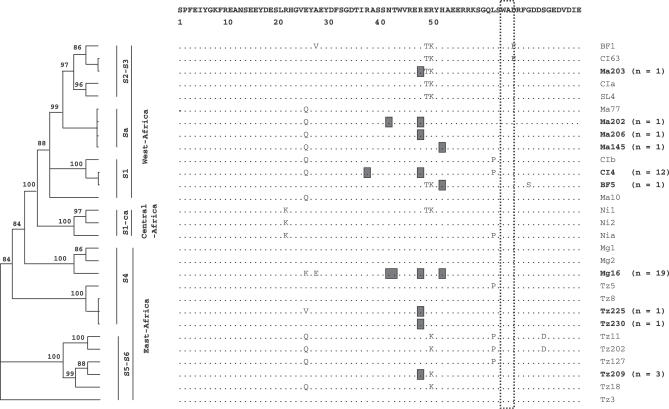
Positions of the Amino Acid Changes Associated with Virulence in the VPgA total of 41 virulent variants generated by inoculating ten wild isolates (names in bold characters) was analyzed. The number of virulent variants analyzed from each of the ten wild isolates is indicated in brackets after the isolate name (right). The amino acid differences between the sequences of the wild isolates of the VPg and the consensus sequence (at the top) are indicated in plain letters. Positions of the amino acid changes associated with virulence are boxed (in black). They were deduced from comparison between the sequences of the VPg of the wild avirulent and the derived virulent forms of each isolate. The large dotted rectangle indicates the conserved WAD motif of the sobemoviruses. The taxonomic positions of the isolates are inferred from the cladogram of 22 reference isolates reconstructed by maximum likelihood from their full sequence with bootstrap support of the nodes, strain, and geographical origins indicated (left). The seven additional isolates were assigned to the closest reference isolate after phylogenetic analyses of their coat protein.